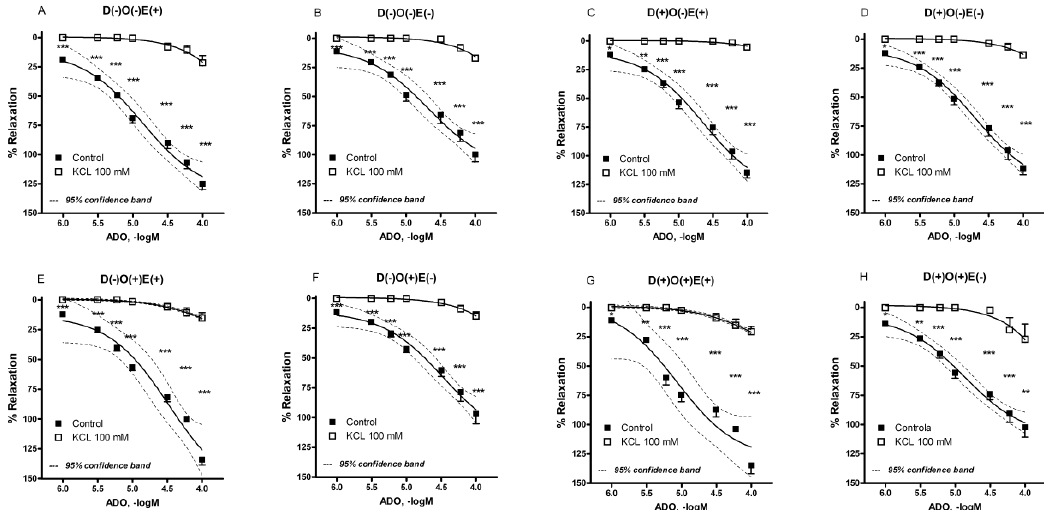
Figure 5. Adenosine-induced relaxation in isolated rat femoral artery in the presence of hyperpolarizing solution (KCl = 100 mM). The femoral artery was obtained from non-diabetic ( A , B , E , F ) and diabetic animals (C , D , G , H ). Additionally, femoral artery was occluded in randomly selected non-diabetic ( E , F ) and diabetic animals ( G , H ). Each point is presented as the mean ± S.E.M ( n = four to eight). Adenosine-induced vascular relaxation is expressed as the percentage of pre-contraction induced by phenylephrine. * p < 0.05, ** p < 0.01, *** p < 0.001. E = endothelium; D = diabetes; O = occlusion.